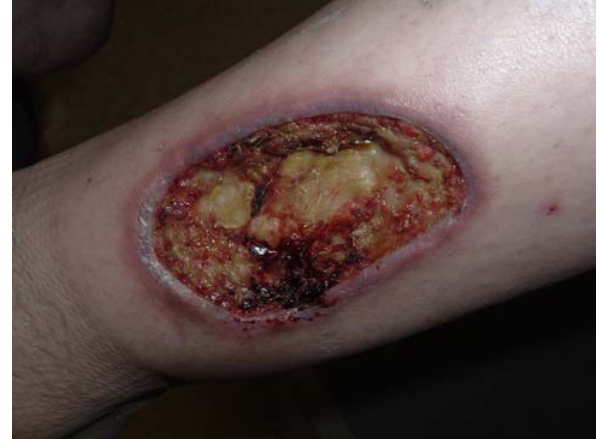
Figure. Pyoderma gangrenosum–like lesions due to